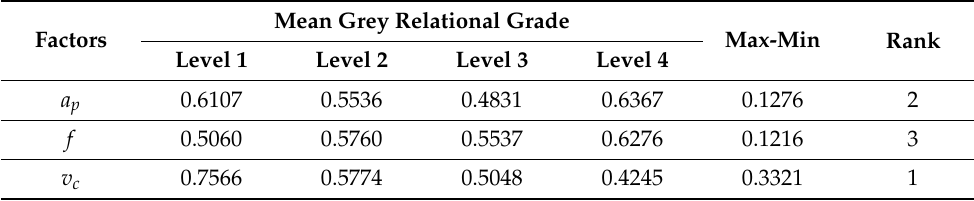
Table 7. Results of ANOVA on grey relational grade.